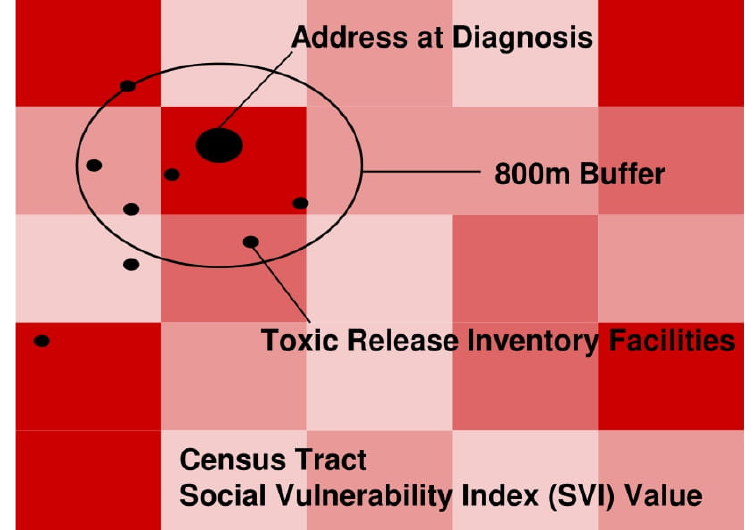
Figure 1. For each patient, an 800-m buffer was drawn circling their address at diagnosis and the average SVI score for the year 2018 was individually coded. The Environmental Protection Agency’s (EPA’s) Toxic Release Inventory (TRI) serve as another marker of risk in the home environment of each patient [23]. Geographic X, Y coordinates pinpoint each facility’s location. Using the 800-m buffer, the number of TRI facilities as well as the mean and median chemical release values reported by these facilities for the years 2000, 2010, and 2020 were calculated for each